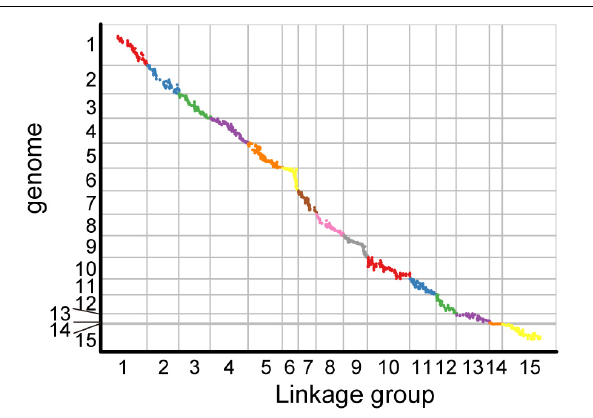
FIGURE 4 | Collinearity analysis of the genetic map and genome based on the arrangement order of markers on genetic map.